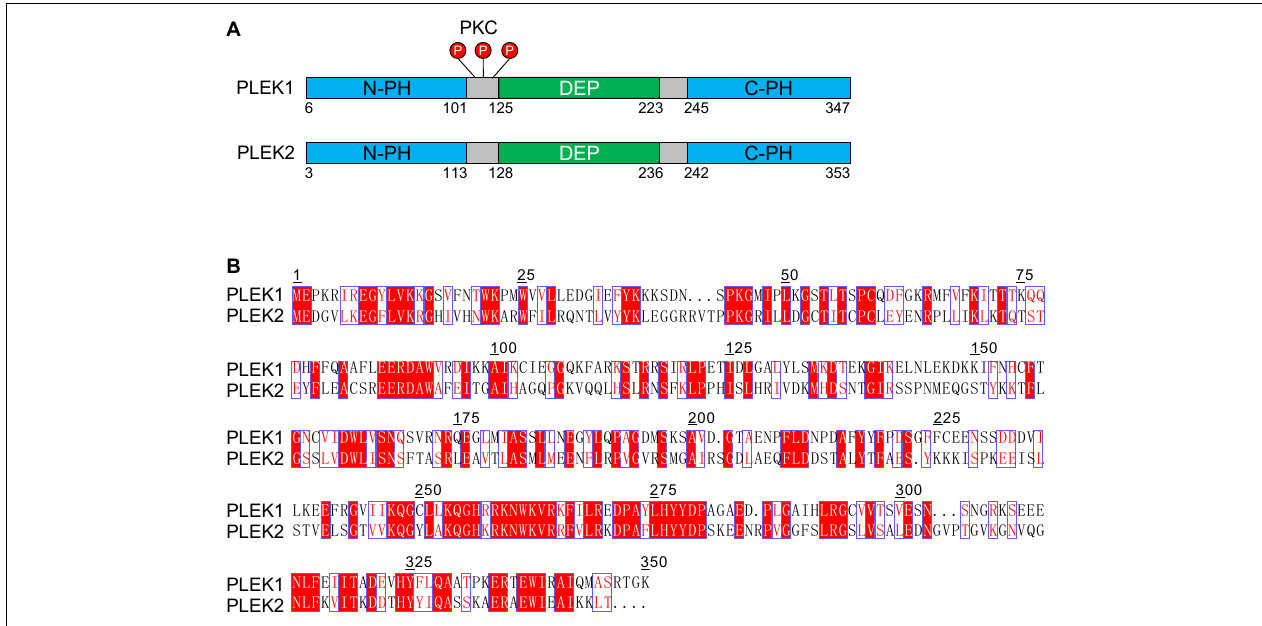
FIGURE 1 | The pleckstrin family of proteins. (A) Structural domain overview of human PLEK1 and PLEK 2. Both PLEK1 and PLEK1 contain two pleckstrin homology (PH) domains (PH, shown in blue) at the amino- and carboxyl-terminal and a central disheveled-Egl-10-pleckstrindomain (DEP, shown in green). There are three sites (Ser113, Thr114, and Ser117) between DEP domain and the N-terminal PH domain of PLEK1, which can be phosphorylated by PKC (shown in red) (B) Comparison of the deduced amino acid sequence of human PLEK1 and PLEK2. The similar amino acids are shown in red, and the same ones are highlighted as red.